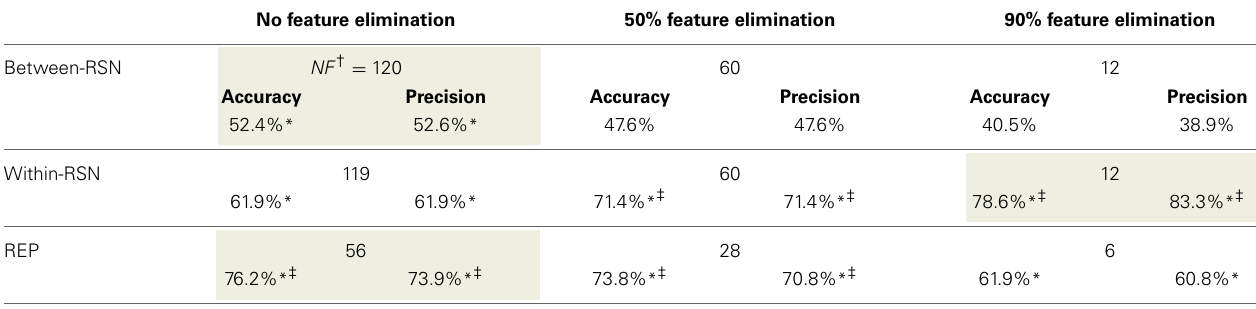
Table 3 | Performance (accuracy and precision) of the three SVM-AdaBoost Classifiers.